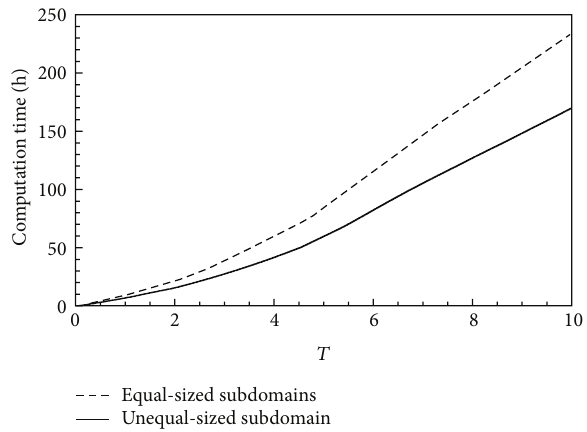
Figure 1: Computation times for equal- and unequal-sized subdo-